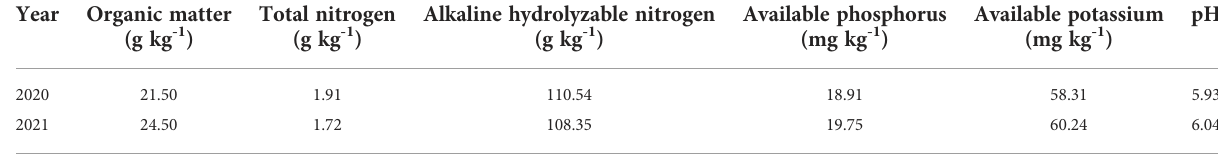
TABLE 1 The basic fertility of the tested